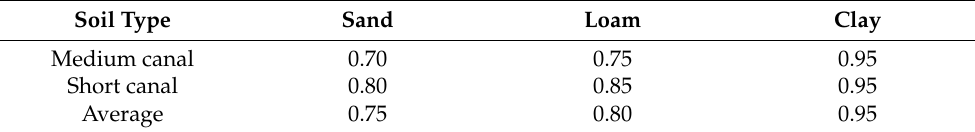
Table 4. Conveyance efficiency depending on the soil